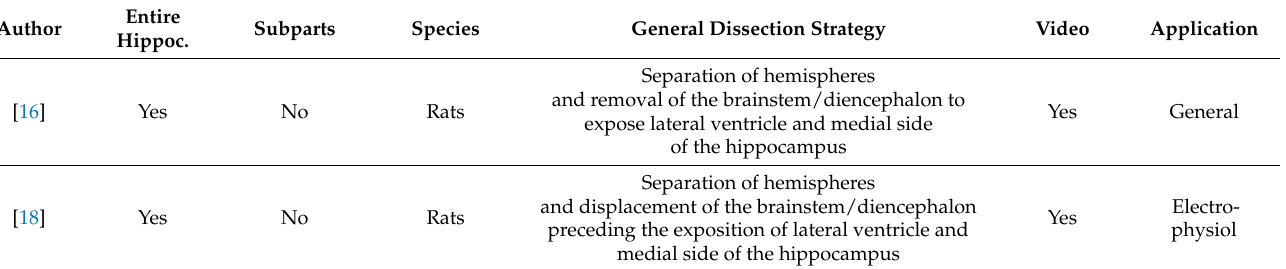
Table 2. Summary of available protocols for gross dissection of hippocampus or its parts in